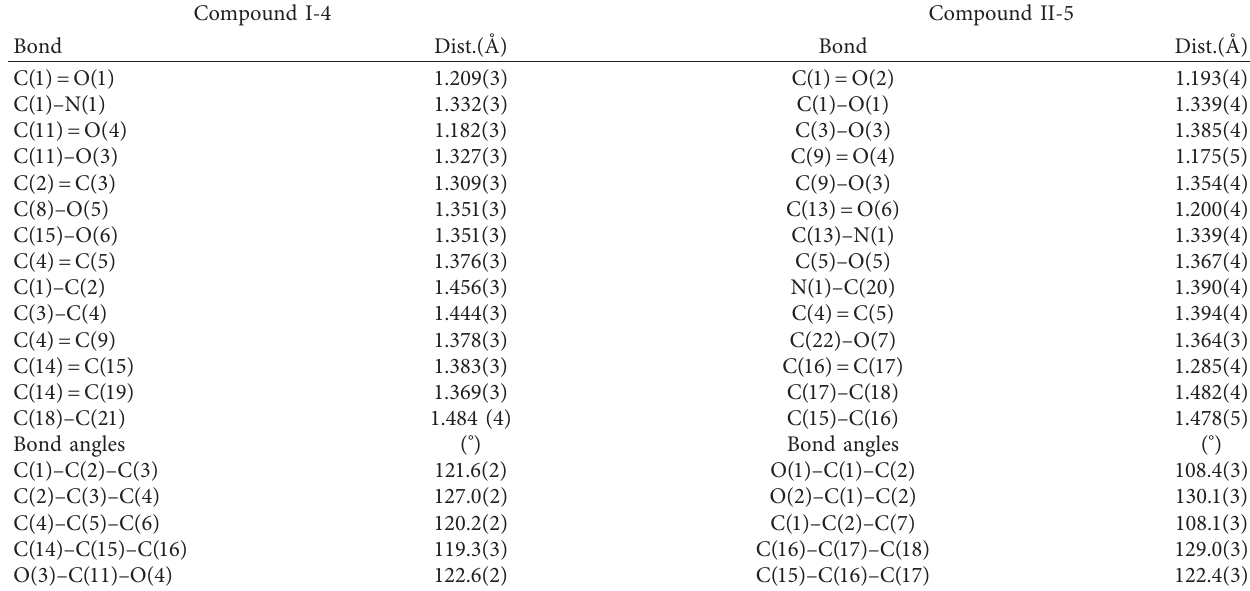
Table 1: Selected bond lengths (˚A) and bond angles ( ° ) for the compounds I-4 and